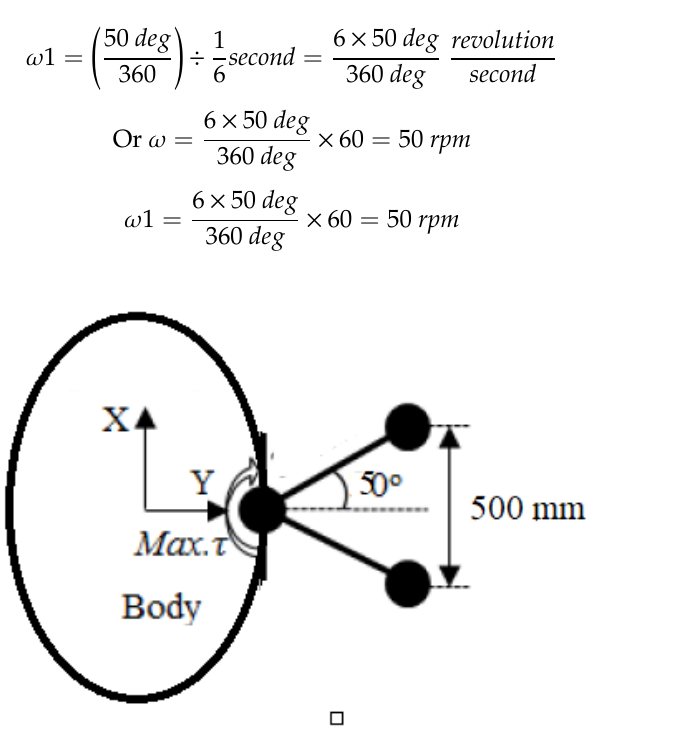
Figure 13. Configuration for deriving angular velocities.